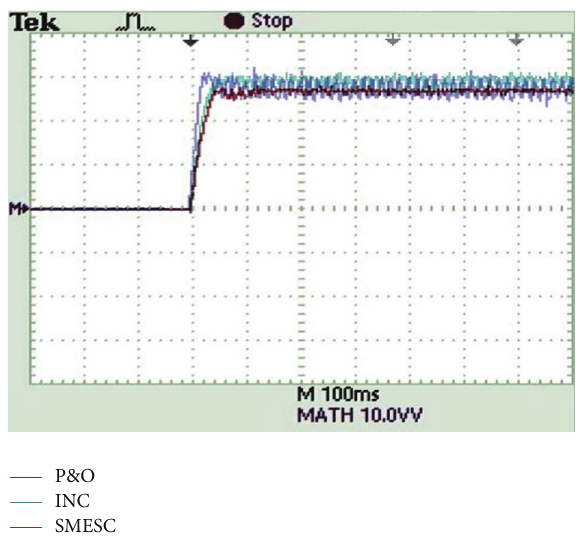
Figure 19: Comparison of experimental results obtained using P&O, INC, and SMESC